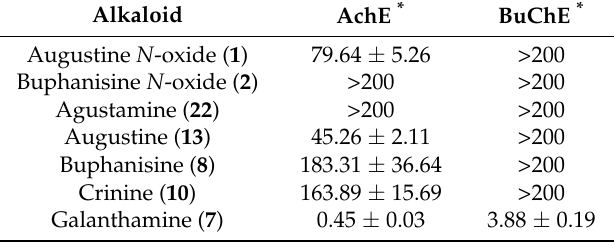
Table 3. Results of AChE and BuChE inhibitory activities of the alkaloids isolated from C. amabile .